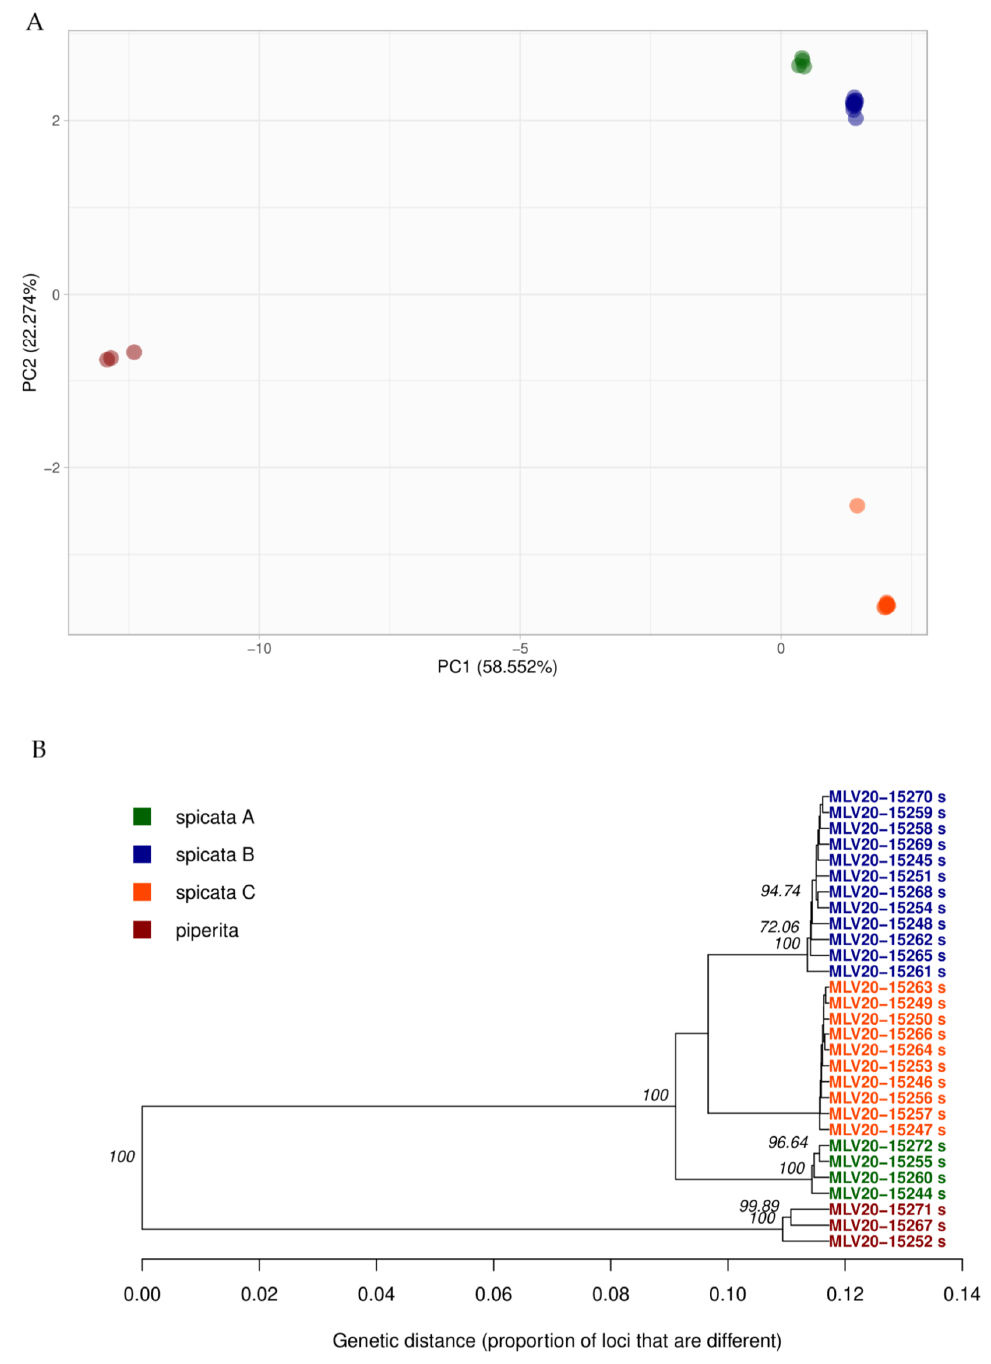
Figure 1. Overall diversity patterns in mint from the northwest Andes. ( A ) PCA analysis from 2033 loci distributed in 912 transcripts. The first component explained 58.56% of the variance, and the second component explained 22.27% of the variance (both totaling 80.83% of explained variance). Clustering validation was performed using the algorithms NbClust and optCluster , which suggested a total of four clusters: three of M. spicata (spicata A, spicata B and spicata C) and one of M. × piperita . All clusters were recovered by the first two components. ( B ) Dendrogram carried out by UPGMA analysis from 2033 variants distributed in 912 transcripts using Nei’s distance and bootstrap as resampling method with 10,000 replicates. These results also suggested a total of four clusters: three from M. spicata (spicata A, spicata B and spicata C) and one for M. × piperita . Clusters under both approaches in ( A , B ) are fully